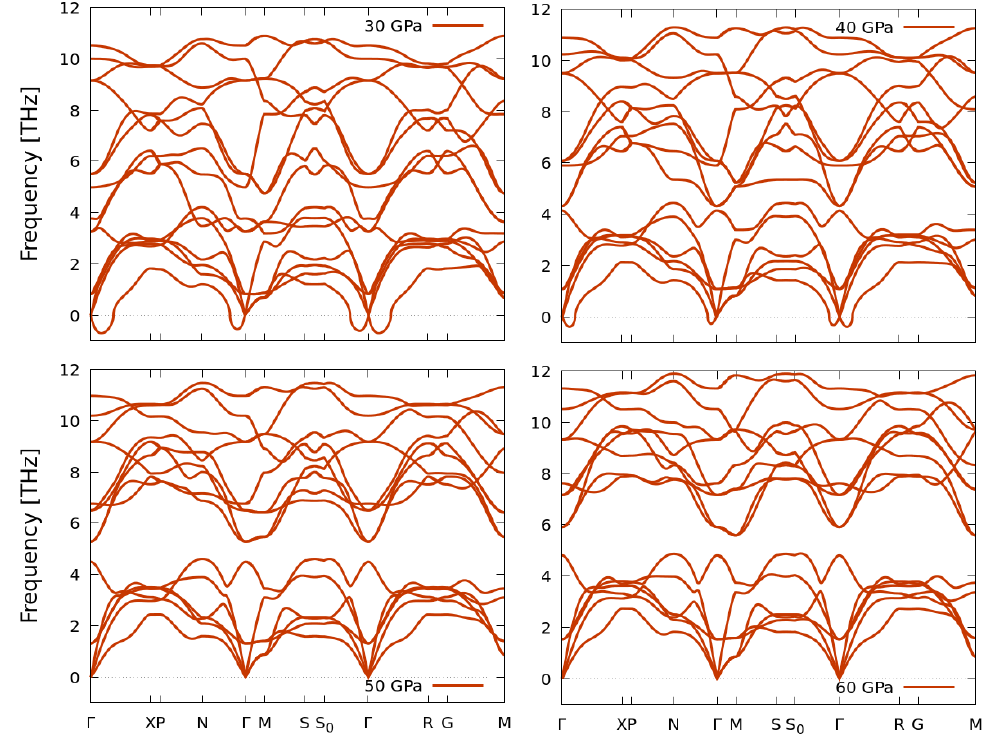
Figure 7. Harmonic phonon dispersion curves of the I4/mmm phase of the Bi 2 S 3 compound between 30 and 60